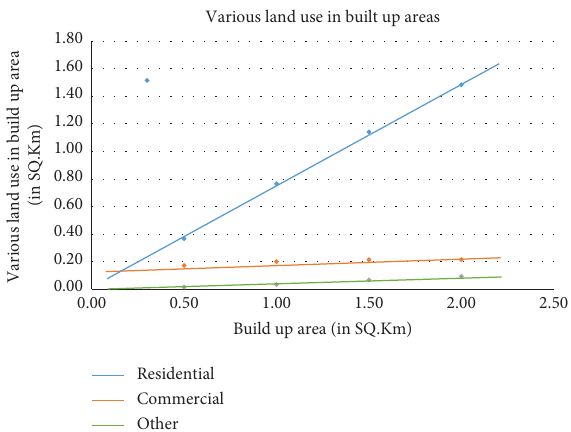
Figure 6: Various land use in build-up areas.